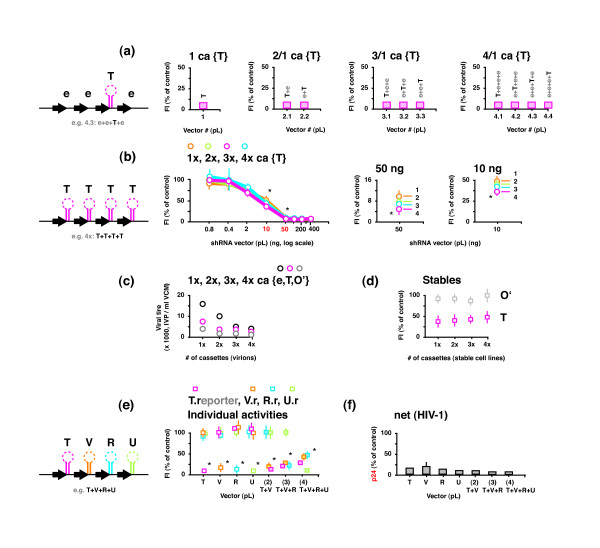
Activities of individually expressed shRNAs from the same vector. (a) 400 ng each of a series of 1, 2, 3 and 4 cassette (ca) pLenti6 (pL) based vectors with only a single hairpin per vector (surrounded by 'empty' expression cassettes) were assayed with 300 ng each of T.r (target-specific) and V.r-red (control) (n = 3). (b) 0 - 400 ng each of a series of 1×, 2×, 3× and 4× cassette pL vectors with all cassettes containing a T shRNA were assayed with 300 ng each of T.r and V.r-red. Total DNA delivered was kept constant at 1 μg by supplementing samples (as required) with the corresponding empty control vector. Statistically significant improvements in suppressive activity (*; P < 0.05) at 10 and 50 ng are shown at a finer scale (comparing the single cassette vector to the 2, 3, and 4 cassette vectors). (n = 3) (c) Viral titres of the Infectious virus produced from the 1×, 2×, 3× and 4× all T cassettes vectors, and the corresponding off-target (O') and empty ("e") series (n = 1). (d) Stably integrated HEK293a cell lines for the 1× - 4× T, O' and e cassette vectors were assayed with 300 ng each of T.r and V.r-red, plus 400 ng of the appropriately matched 1 - 4 e cassette vector (to maintain a constant transfection amount of 1 μg) (n = 1). (e) 400 ng each of single shRNA vectors and a series of 1, 2, 3 and 4 cassette vectors made from 4 different shRNAs (T, V, R, and U) were separately assayed with 300 ng each of the 4 corresponding GFP fusion reporters T.r, GFPsVif (V.r), GFPsVpr (R.r) and GFPsVpu (U.r) plus 300 ng of an AsRed1sNef control (N.r-red). (*) There was a statistically significant reduction in the individual suppressive activities of each hairpin relative to their single counterparts (P < 0.01) (n = 1). (f) Net suppressive activities of the same vectors were measured using a HIV-1 production assay by transfecting HEK293a cells with 110 - 130 ng of shRNA vector with 800 ng of pNL4-3 reporter and measuring the impact on p24 production (n = 2).